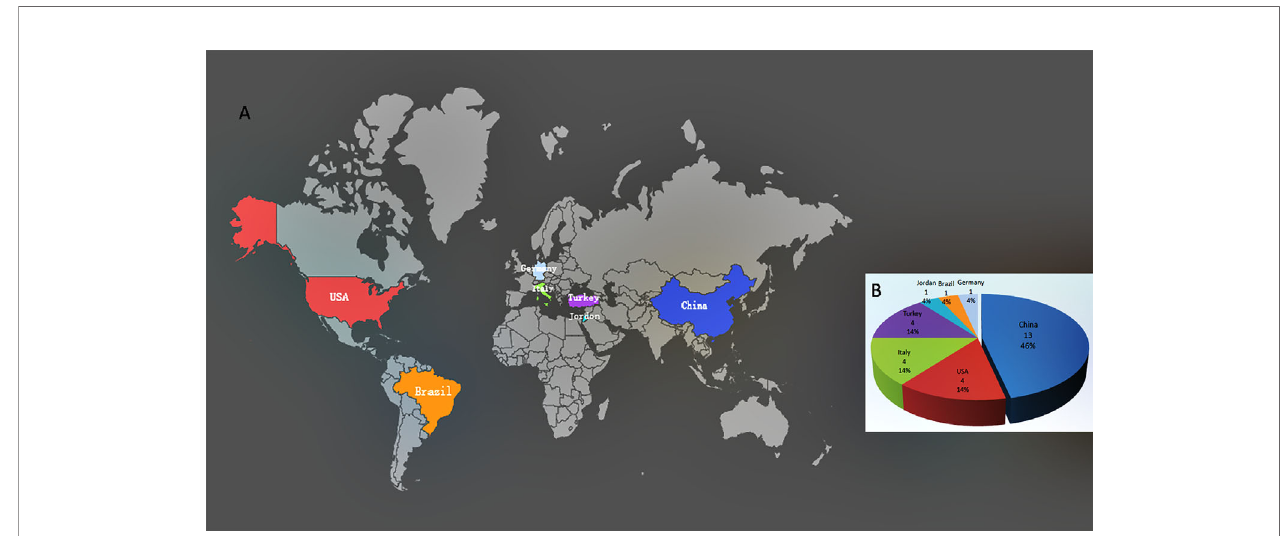
FIGURE 2 | Distribution and proportion of included studies. (A) Distribution of 28 included studies. (B) Proportion of 28 included studies in seven